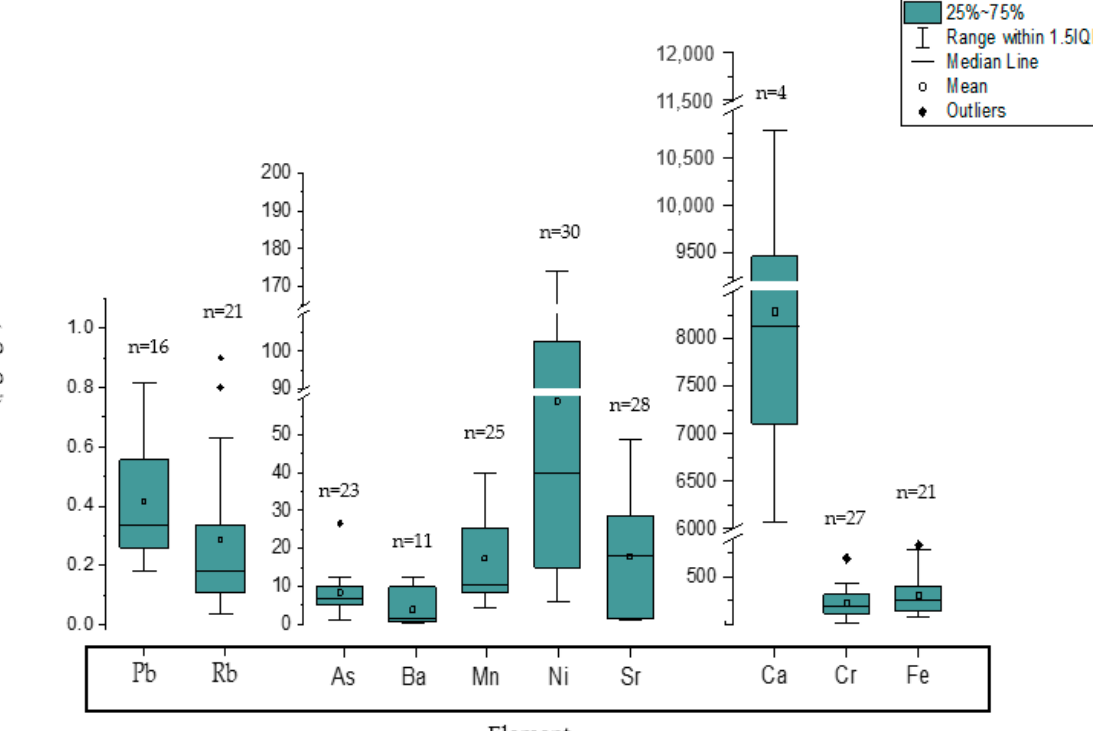
Figure 3. Trace element concentrations in olive oil originating from: Italy, Spain, Tunisia, Portugal, Croatia, Cyprus, Turkey and Greece. (n = number of articles).